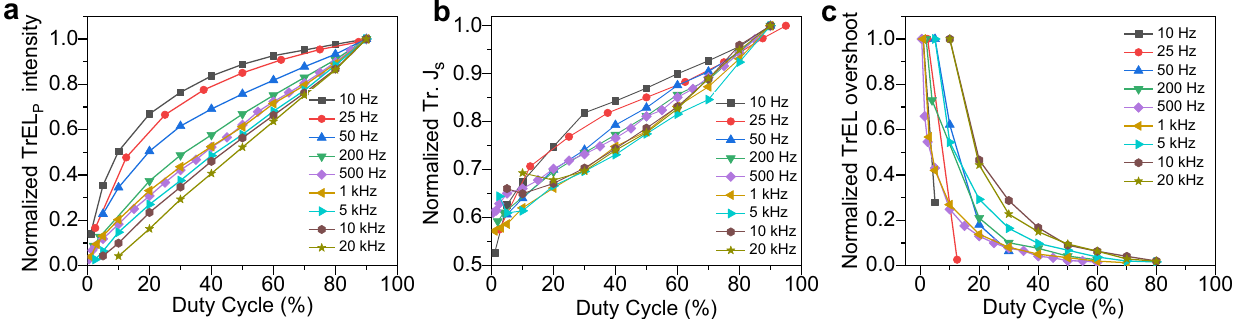
Fig. 3 Transient electroluminescence (TrEL) dynamics versus the duty cycle as a function of driving frequency. a Normalised TrEL P intensity versus the duty cycle. For this fi gure, we use plateau values (TrEL P intensity values at the end of the TrEL pulse) from the TrEL data, which are recorded for different pulse widths in the range of 10 Hz to 20 kHz (Supplementary Figs. 3 to 11). b Normalised saturated transient current density (Tr. J S ) versus the duty cycle. c Normalised TrEL overshoot intensity versus the duty